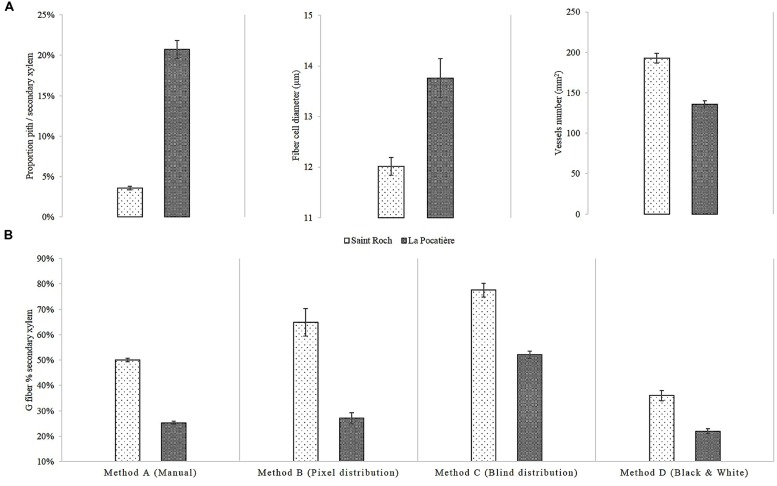
SX64 cultivar (S. miyabeana) in its third year of a harvest cycle sampled at two field trials in Québec: Saint-Roch-de-l′Achigan and LP.
(A) Measured Anatomical traits: (i) pith proportion, (ii) fiber cell diameter, and (iii) vessels number per 1 mm2; (B) Variation of G fibers determined by different image analytical methods: Method A (Manual) involved manual drawing around stained g-fiber, Method B (Pixel distribution) quantified pixels in a bin from 0 to 100, Method C (Blind distribution) quantified pixels in a bin from 0 to 127 and Method D (Black and White) count black pixels of monochrome. Error bars represent standard error (n = 3 trees, one per randomized block). All comparisons between Saint Roch and La Pocatiere presented in this figure are significantly different (t-test, p < 0.05).